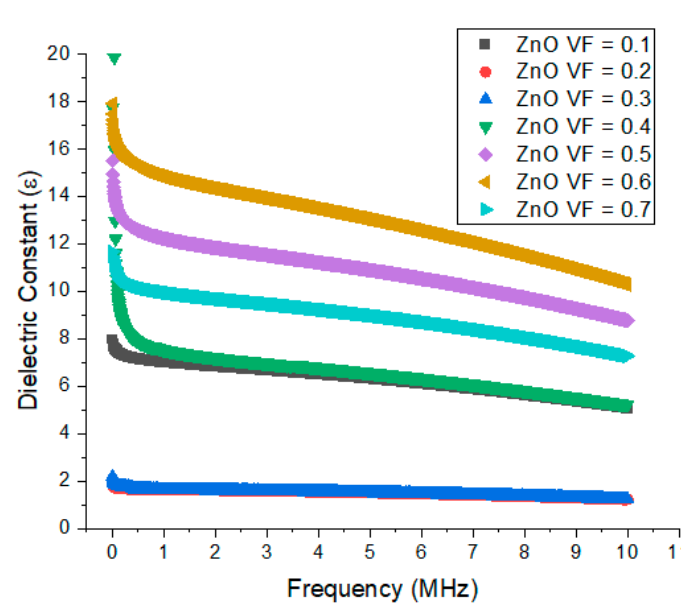
Figure 8. Variation of the Dielectric Constant spectrum for the nanocomposite samples for different volume fractions of ZnO with a change of frequency from 20 Hz – 20 MHz.